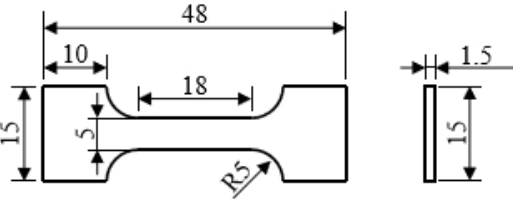
Figure 4. Tensile sample geometry (lengths in mm).